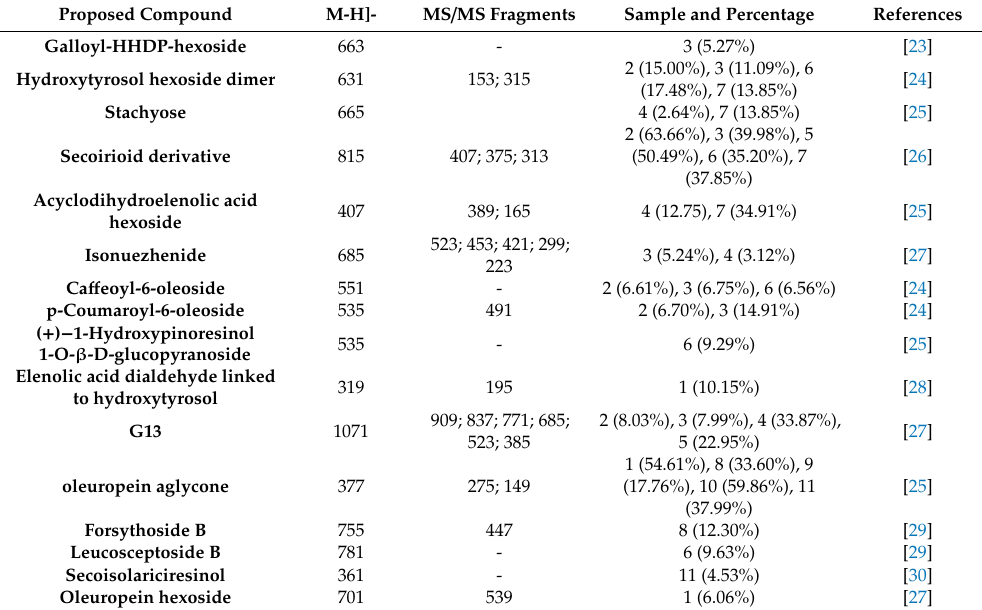
Table 4. Polar compounds determined in olive oil, paste, and